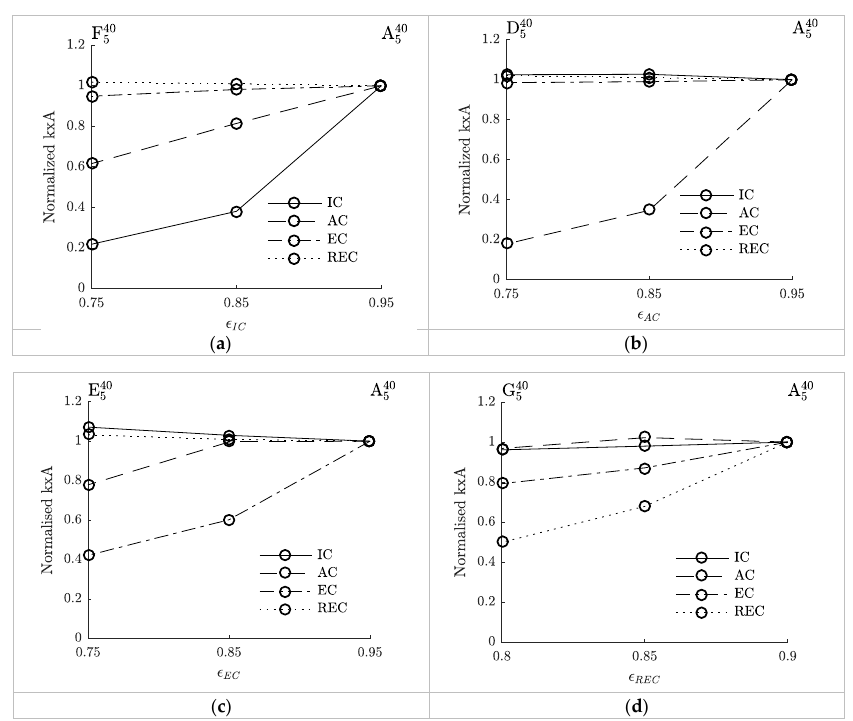
Figure 6. ( a ) normalized inverse total resistance, k × A of each heat exchanger vs. intercooler effectiveness ( (cid:1827) (cid:2873)(cid:2872)(cid:2868) → (cid:1832) (cid:2873)(cid:2872)(cid:2868) ); ( b ) normalized k × A of each heat exchanger vs. aftercooler effectiveness ( (cid:1827) (cid:2873)(cid:2872)(cid:2868) → (cid:1831) (cid:2873)(cid:2872)(cid:2868) ); ( c ) normalized k × A of each heat exchanger vs. economizer effectiveness ( (cid:1827) (cid:2873)(cid:2872)(cid:2868) → (cid:1830) (cid:2873)(cid:2872)(cid:2868) ); and ( d ) normalized k × A of each heat exchanger vs. recuperator effectiveness ( (cid:1827) (cid:2873)(cid:2872)(cid:2868) → (cid:1833) (cid:2873)(cid:2872)(cid:2868) )— OPR = 40 & ∆(cid:1846) (cid:3043)(cid:3046) = 5 K.